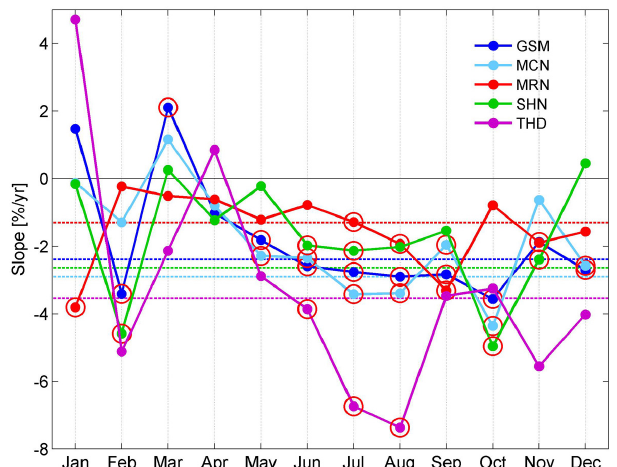
Fig. 5. Seasonal Mann-Kendall trend analysis (red circles corre- spond to 90% confidence levels) associated with Sen’s slopes (col- ored dots) for the scattering coefficients of eastern and northwestern stations. The dotted lines correspond to the annual